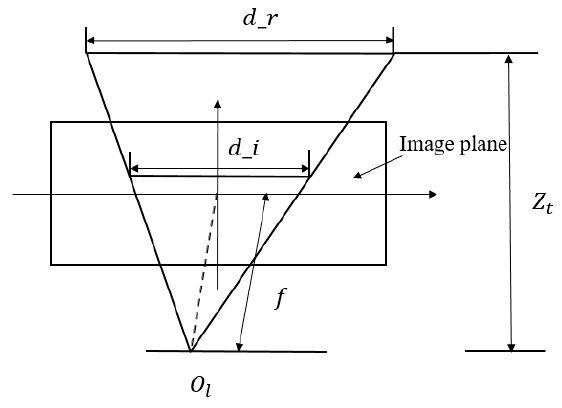
Figure 6. Length prediction.